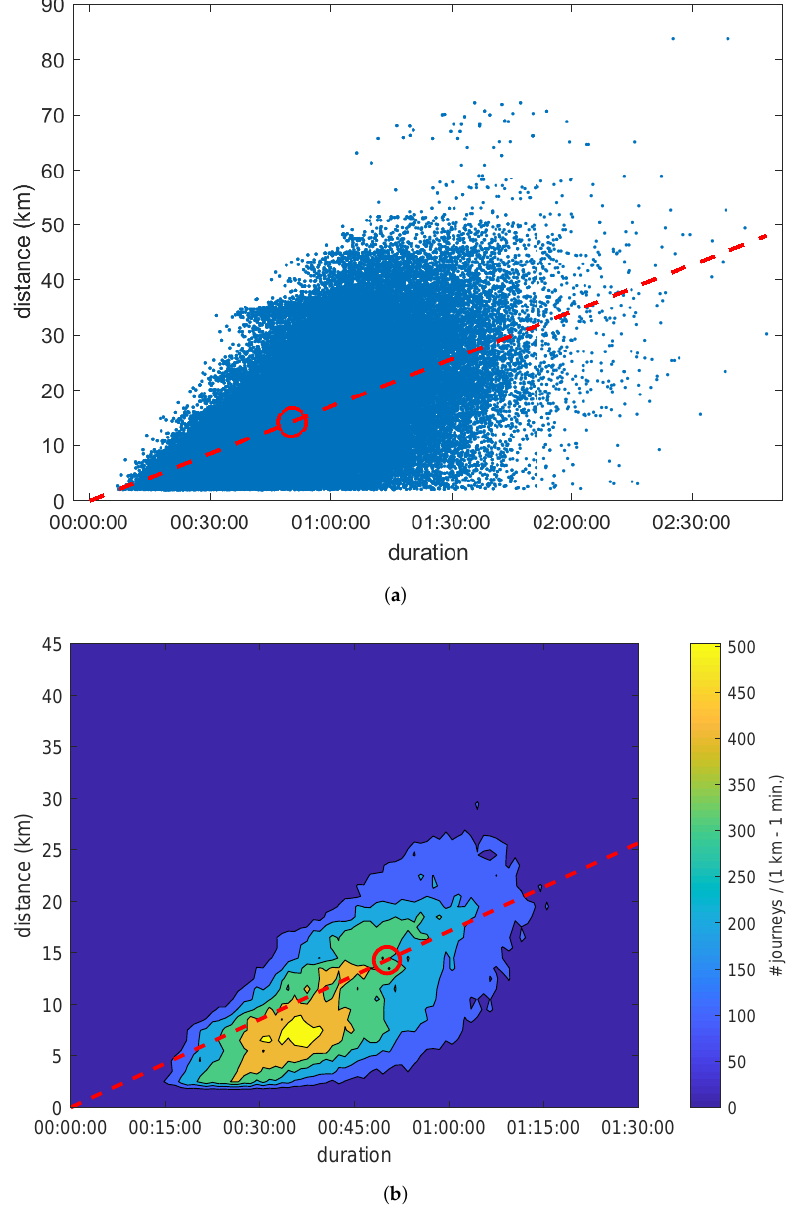
Figure 3. Space-time representation of journeys (23 November 2018): ( a ) points of individual journeys; ( b ) contour